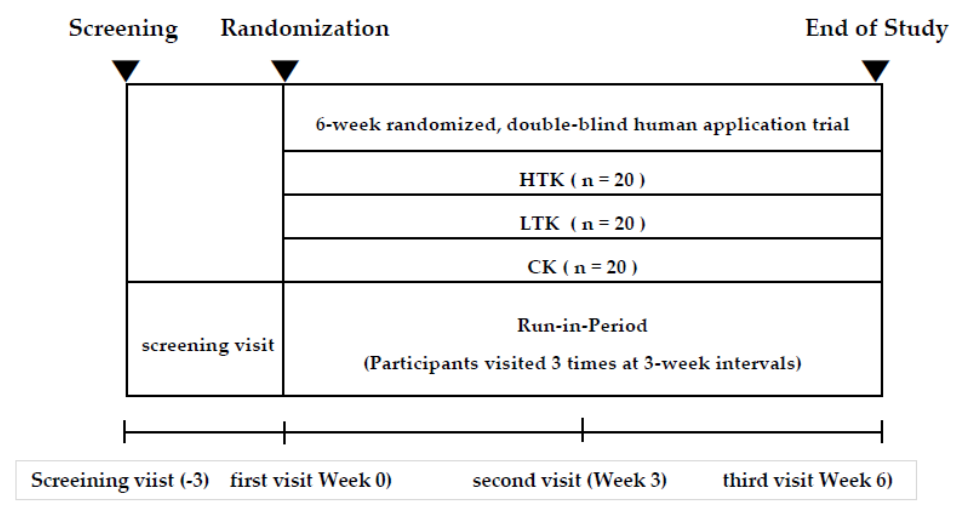
Figure 1. Study design.